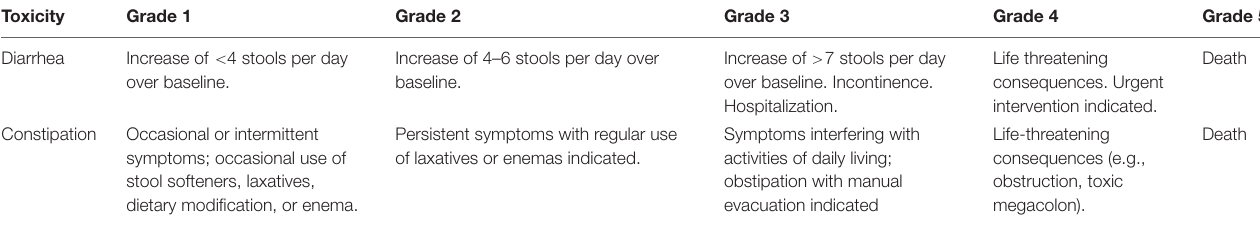
TABLE 2 | Common toxicity criteria for diarrhea and constipation grading (adapted from the National Cancer Institute). Toxicity Increase of < 4 stools per day Increase of 4–6 stools per day over over baseline.